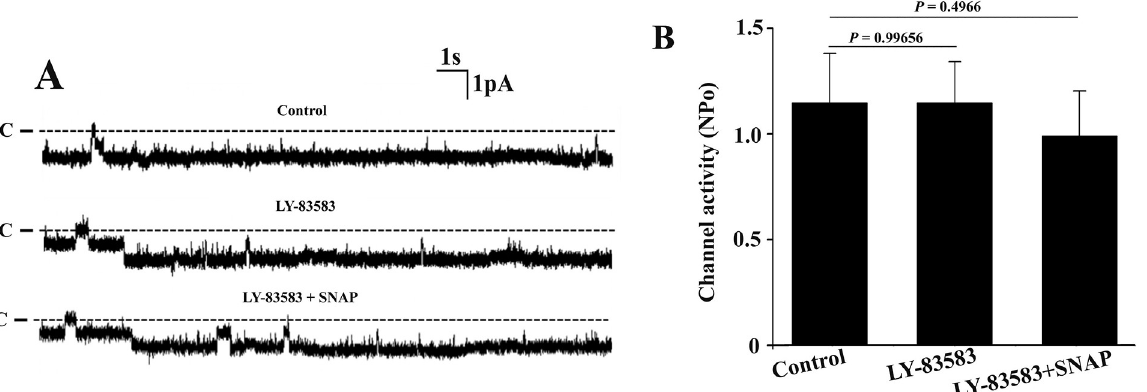
Fig 4. Soluble guanylyl cyclase inhibitor LY-83583 prevents the effect of SNAP on the 10-pS Cl - channels. (A) Representative single channel recordings from the same cell-attached patch under control condition, in the presence of 10 μ M LY-83583 alone as well as in the presence of both LY-83583 (10 μ M) and SNAP (5 μ M). The holding potential was -60 mV and the channel closed level is indicated by the dotted line and “C”. (B) The bar graph showing that LY-83583 eliminates the inhibitory effect of SNAP on the channel.